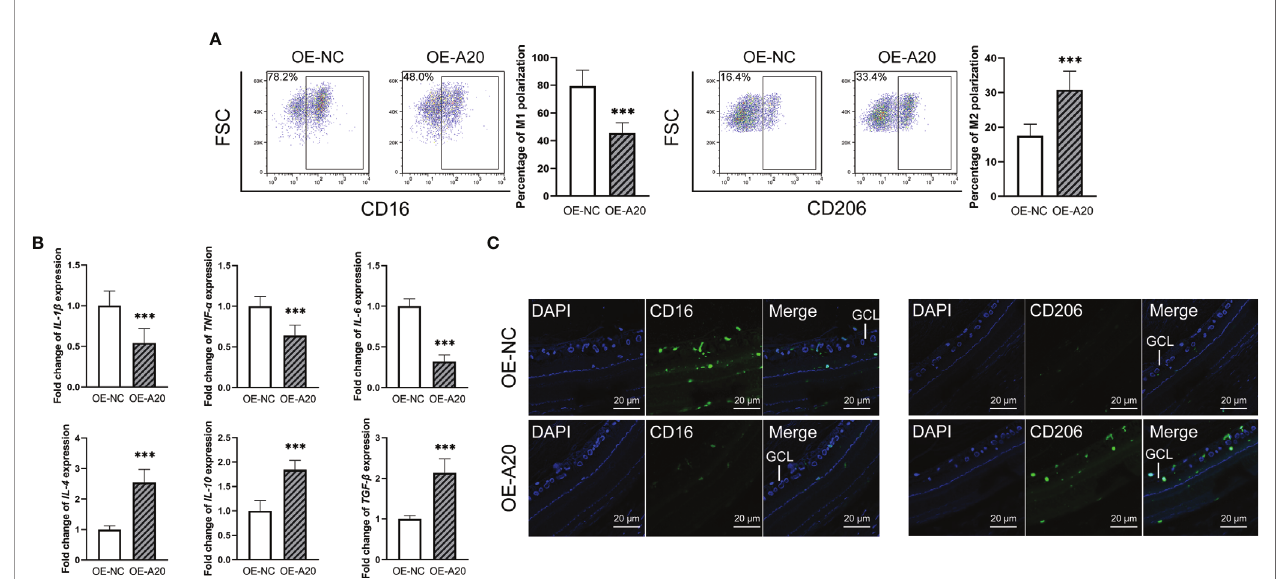
FIGURE 5 | Intravitreal injection of A20-overexpression lentiviruses recti fi ed enhanced M1 polarization of retinal microglia in diabetes rats. (A) The percentage of the CD16 + M1 microglia in the OE-A20 group was lower than that in the OE-NC group. The percentage of the CD206 + M1 microglia in the OE-A20 group was higher than that in the OE-NC group. (B) The mRNA levels of IL-1 b , IL-6 and TNF- a were lower in the OE-A20 group compared to the OE-NC group. The mRNA levels of IL-4, IL-10 and TGF- b were higher in the OE-A20 group compared to the OE-NC group. (C) The OE-A20 group has less CD16 + M1 microglia but much more CD206 + M2 microglia compared to the OE-NC group. Values are presented as the mean ± SD. *** indicates P <